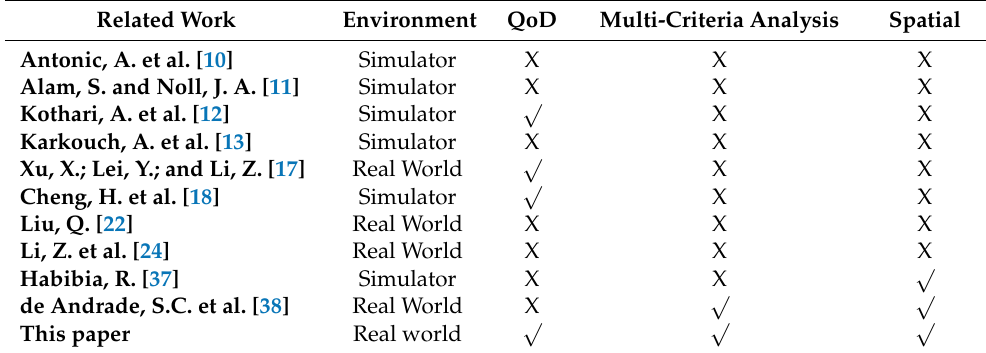
Table 1. Main features of the related